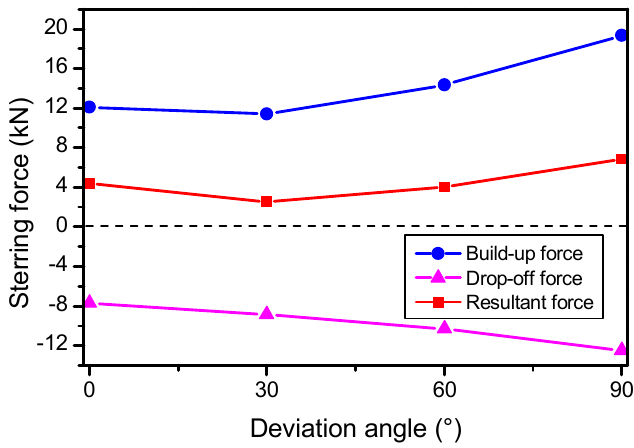
Figure 15. Steering force versus deviation angle.